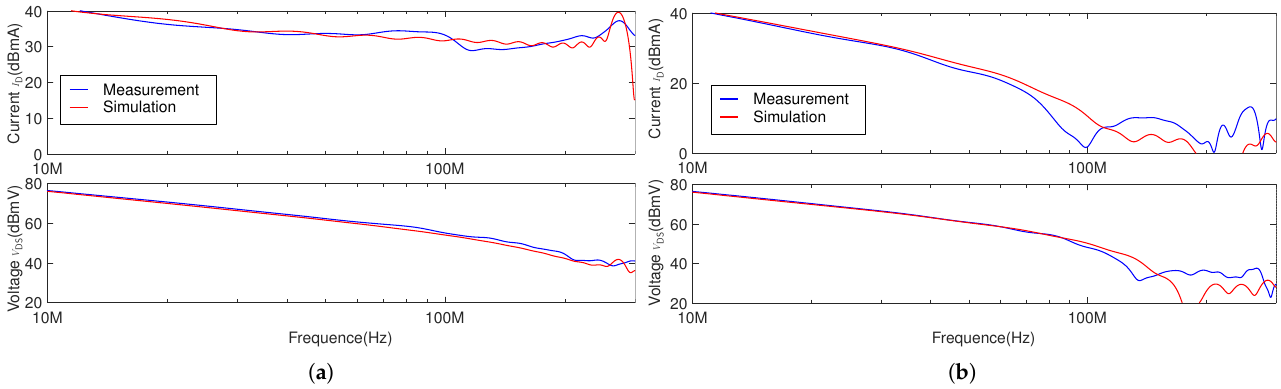
Figure 7. Spectrum comparison between simulation and measurement for I D and V DS magnitude at 200 V/4 A: ( a ) Turn-ON. ( b )